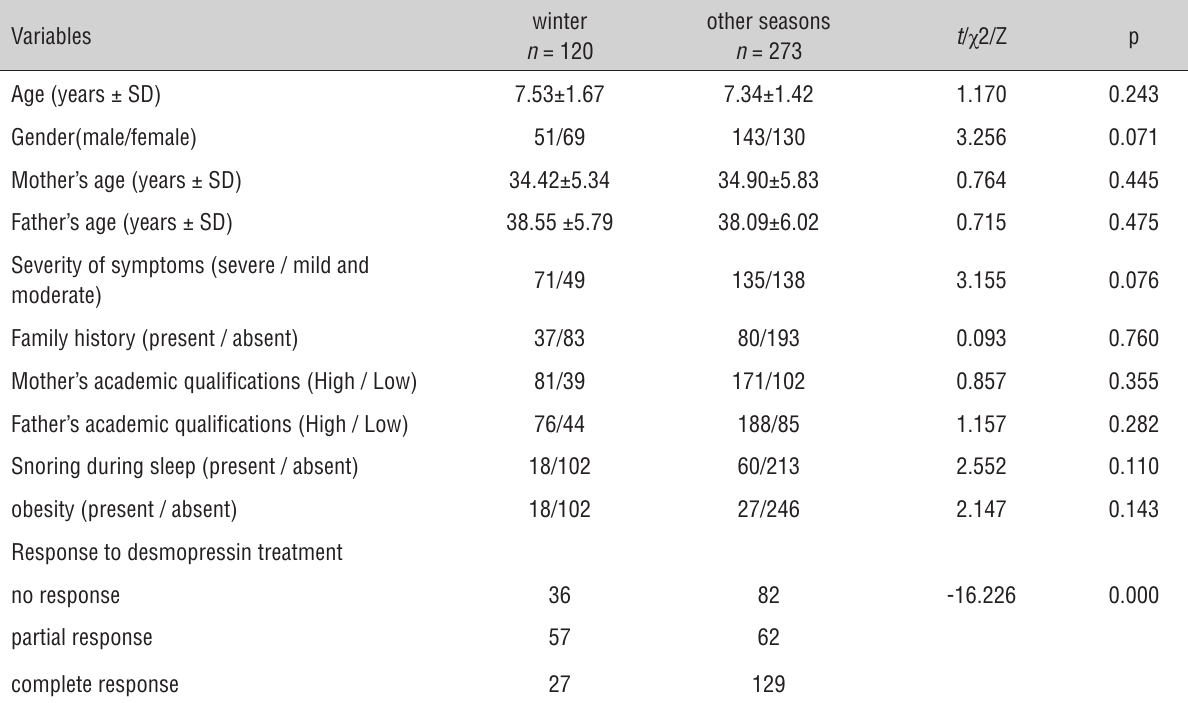
Table 1 - Characteristics of cases for the first visiting urology clinic in winter or other seasons.